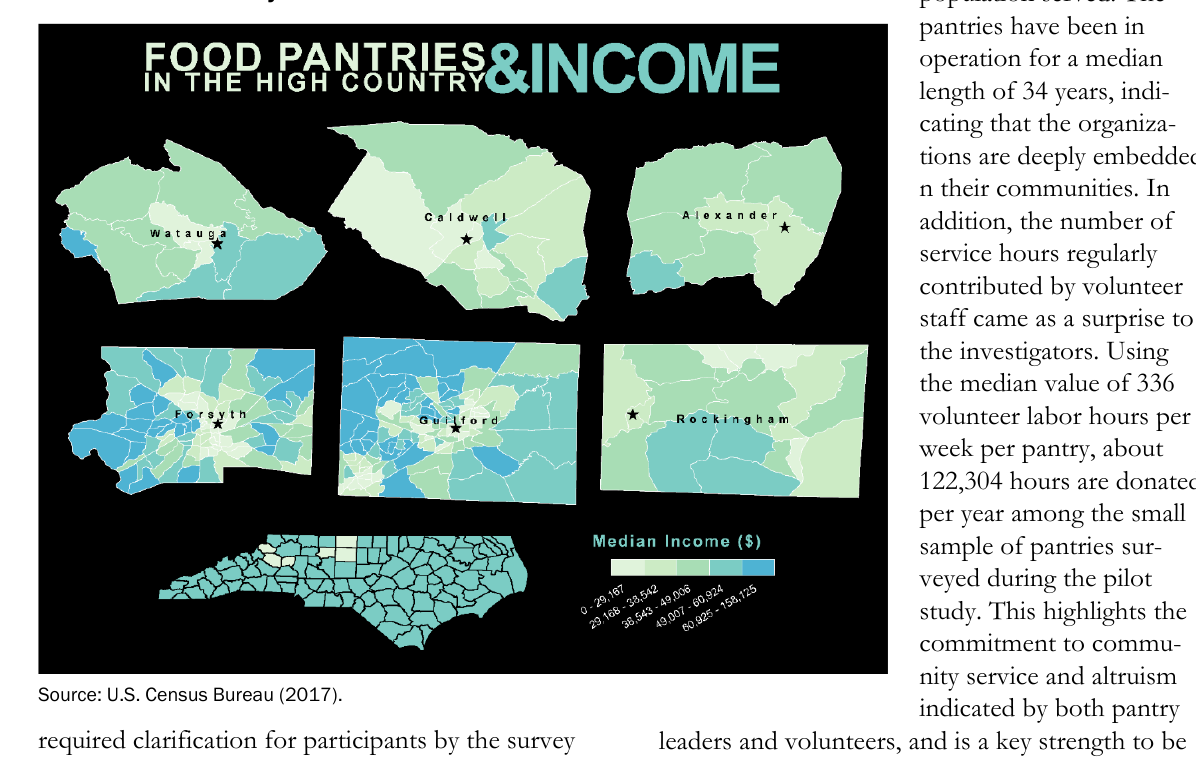
Figure 2. Pilot Study GIS Mapping Example: Median Income at the Census Tract and Food Pantry